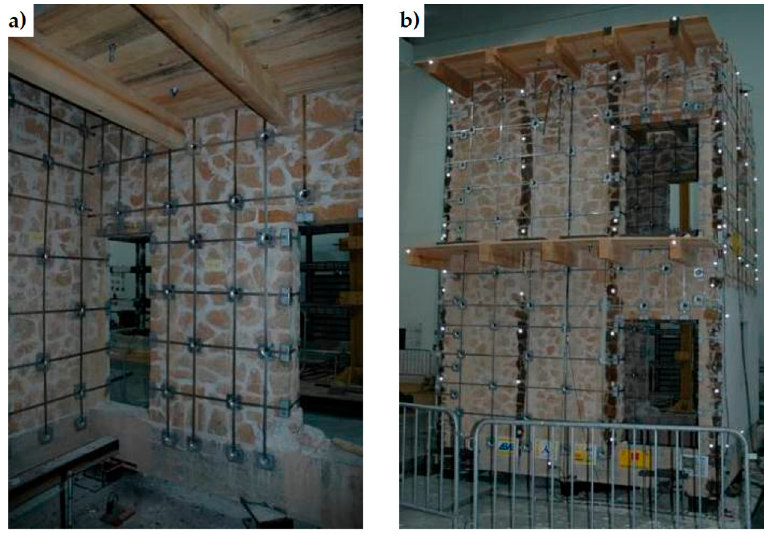
Figure 9. An example of reinforcement with the CAM system: 2:3-scale model for testing on a shaking table [48]: ( a ) internal view; ( b ) external view.